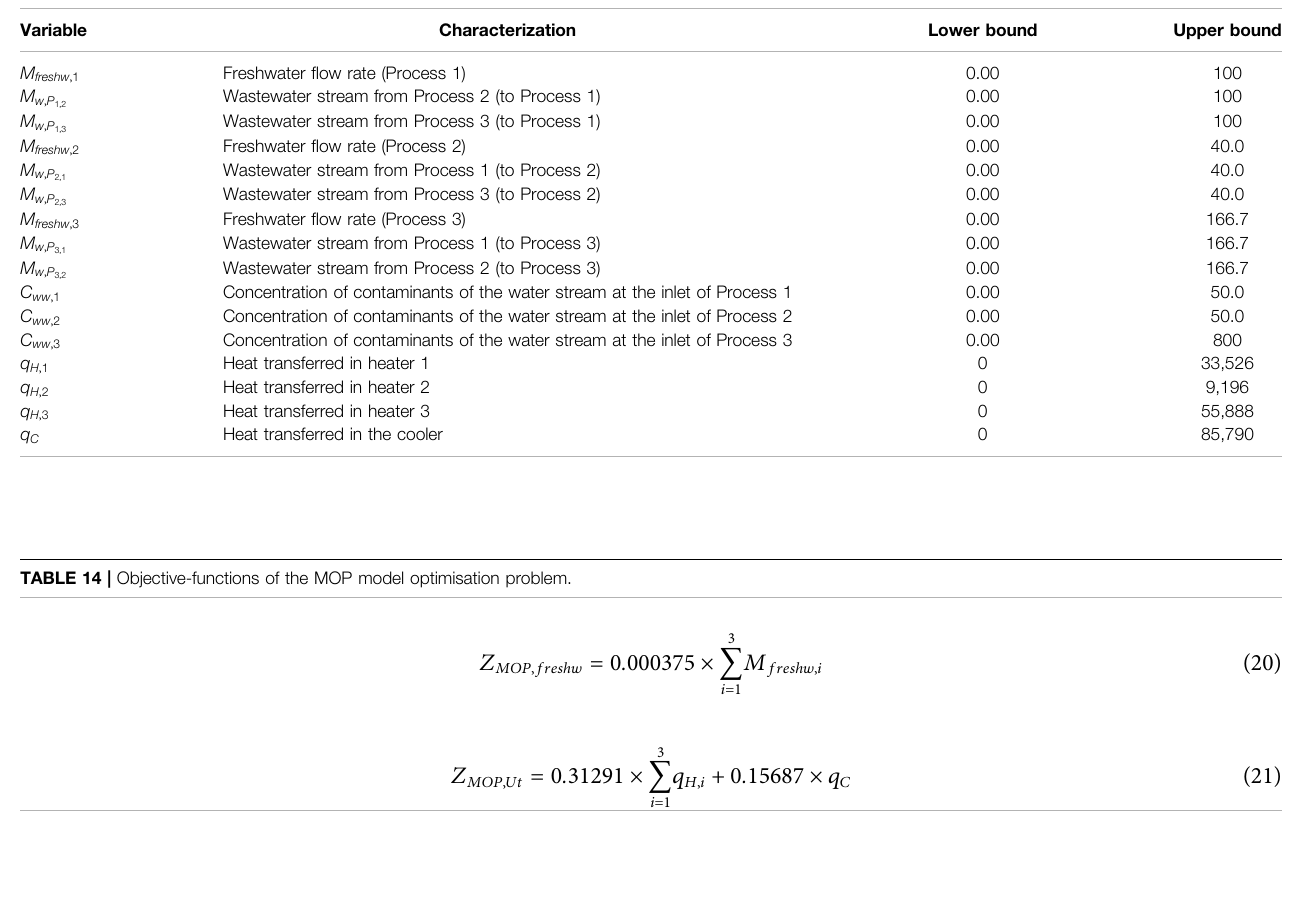
TABLE 15 | Results for the Pareto set (Water and Energy Consumption).